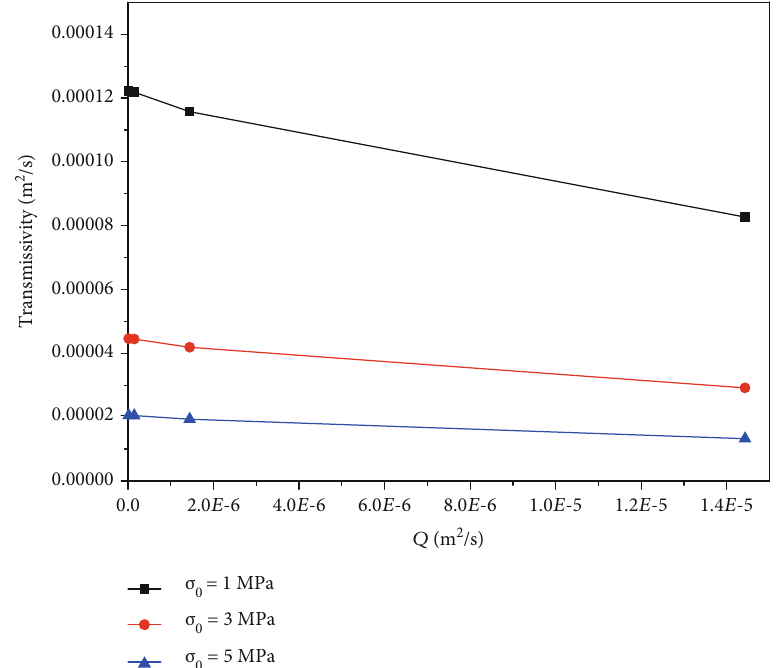
Figure 10: Transmissivity varies with fl ow rate with H = 0 : 6 .